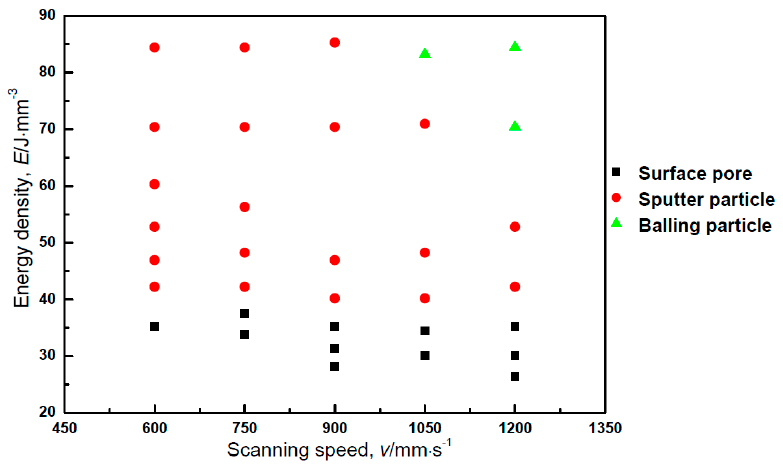
Figure 5. Processing map of the surface morphology at five different scanning speeds and corresponding energy densities.